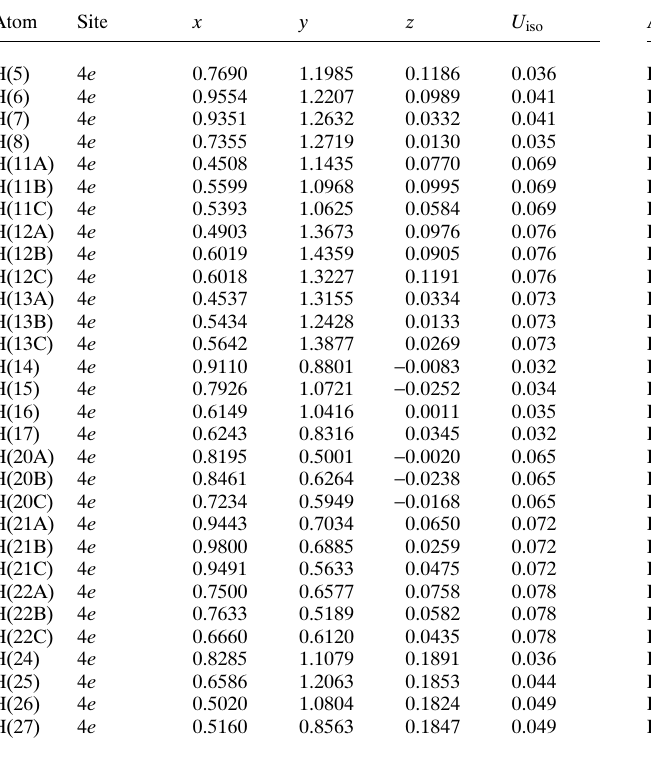
Table 2. Atomic coordinates and displacement parameters (in Å 2 )